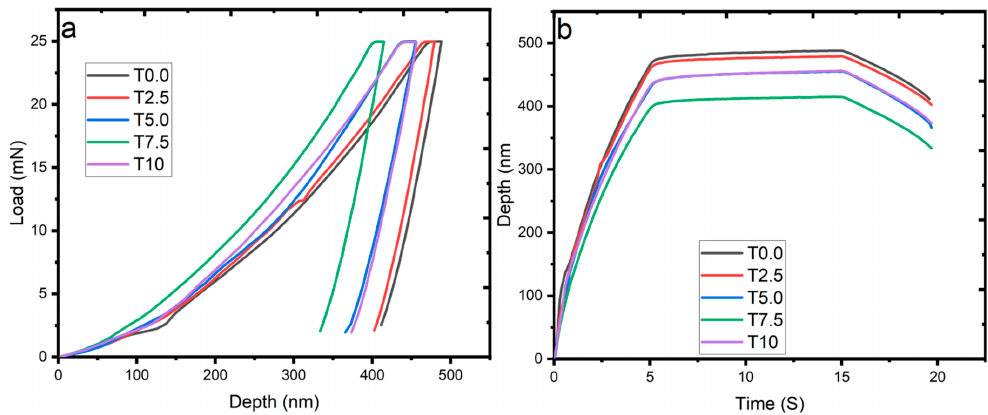
Figure 9. The nanoindentation curves of the sintered samples at the load of 25 mN: ( a ) Load-displacement, and ( b ) Penetration depth as a function of time curves.